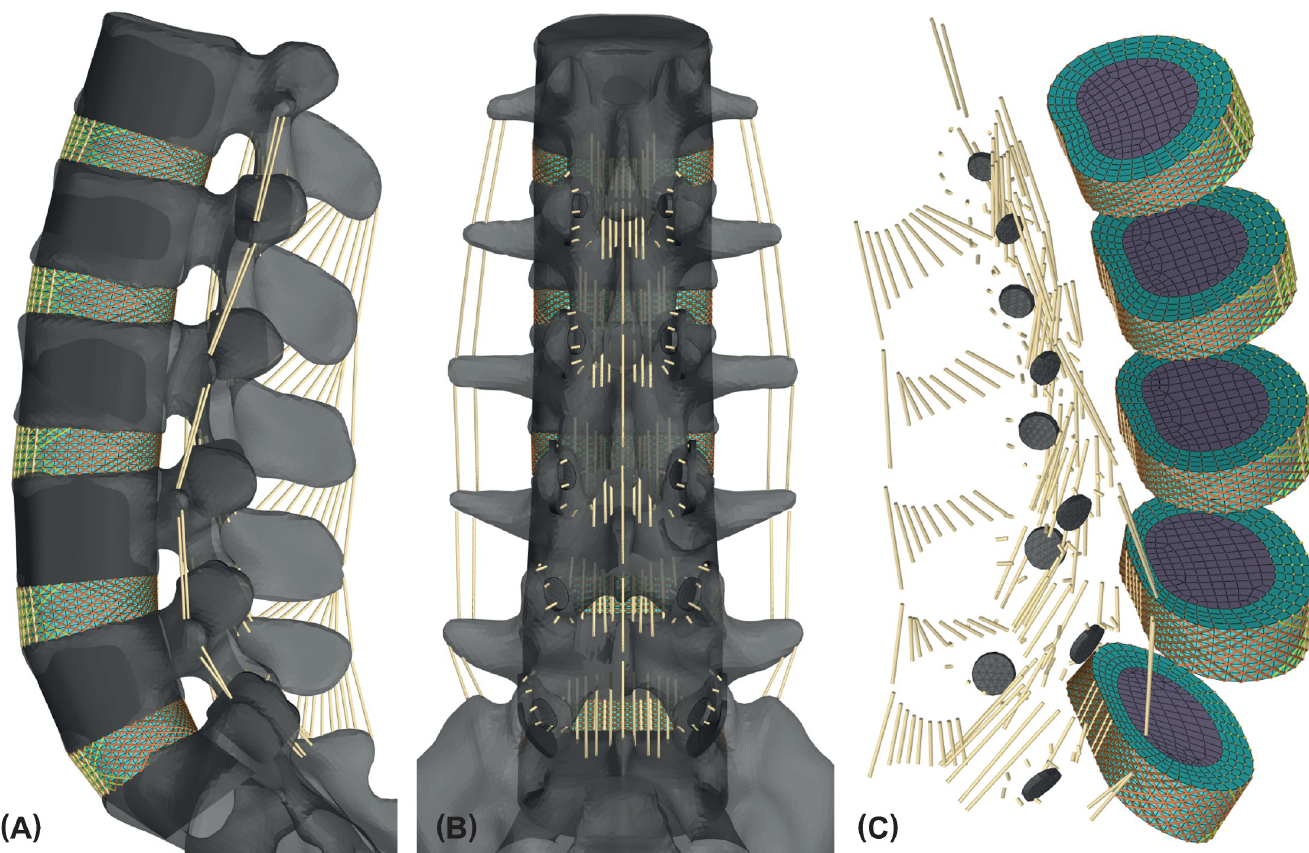
Fig 1. Passive hybrid lumbosacral spine model built in ArtiSynth. (A) Ligamentous LSS (L1 to sacrum) in left lateral view and (B) in dorsal view. Rigid bodies of the vertebrae are shown in light grey and auxiliary vertebral bodies together with the superior articular processes (Fig 2A) are shown in dark grey. (C) All rigid bodies are set invisible. Only the meshed inferior articular facets, the collagen fiber reinforced discs, and the ligaments are visualized. Collagen fibers assigned to different locations are distinguished by color: brown (posterior), orange (lateral), and yellow (anterior).